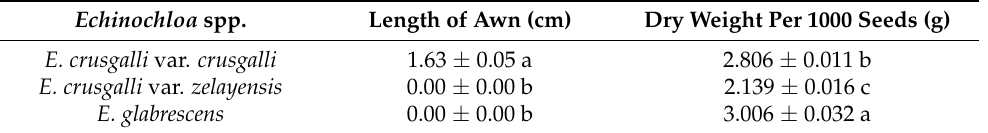
Figure 1. Morphology of three barnyard grass species. ( a ). Comparison of morphology of shoots. ( b ). Differences in the morphology of seeds. Table 1. Differences in seeds of three Chinchaga spp.